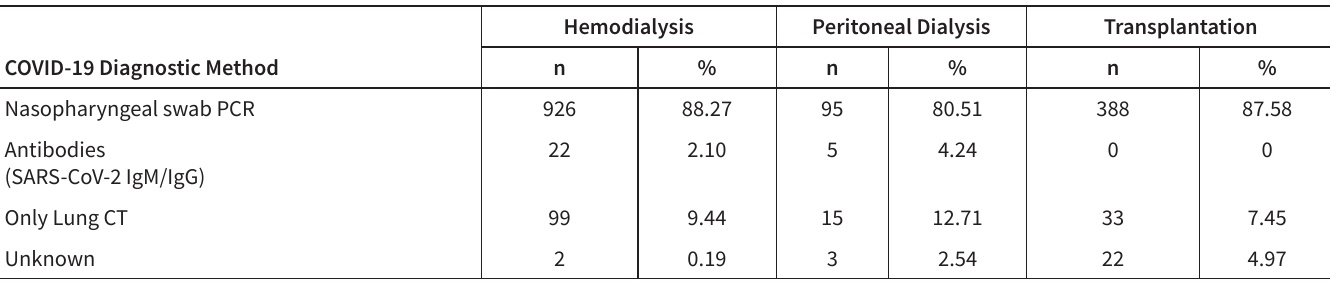
Table 2. Analysis of COVID-19 Diagnostic Methods in Kidney Replacement Therapy Modalities